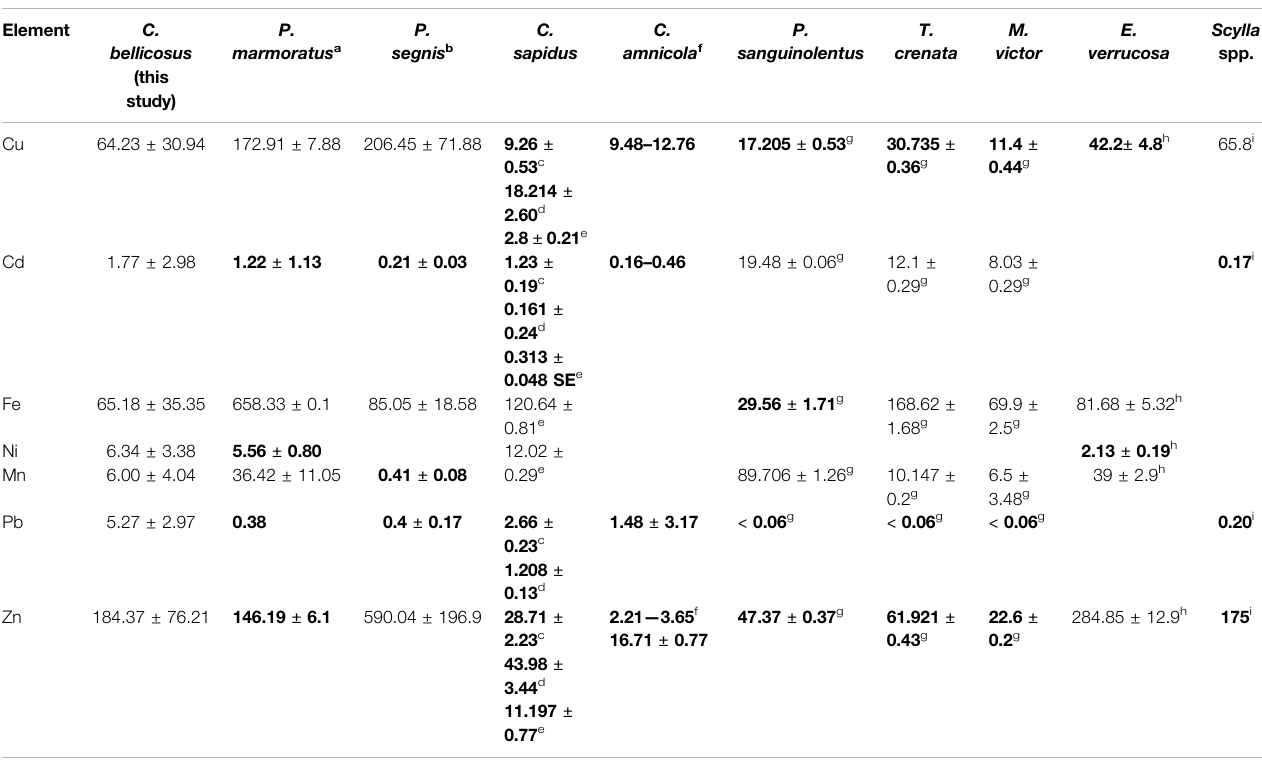
TABLE 1 | Average metal content (mg − 1 kg − 1 ) in muscle tissue of different crab species.